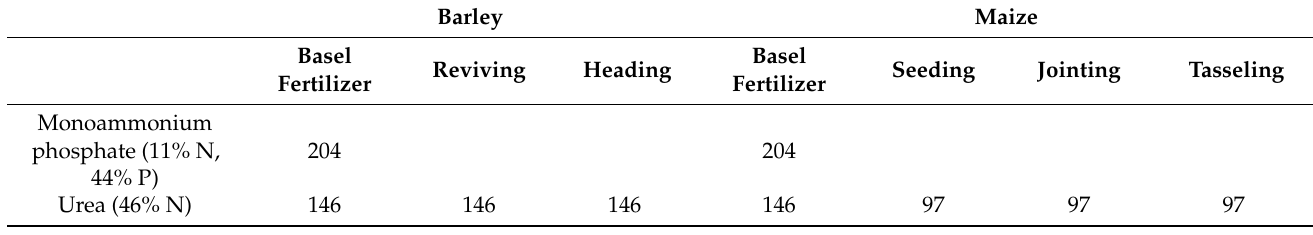
Table 1. Specific fertilization information (kg/ha).